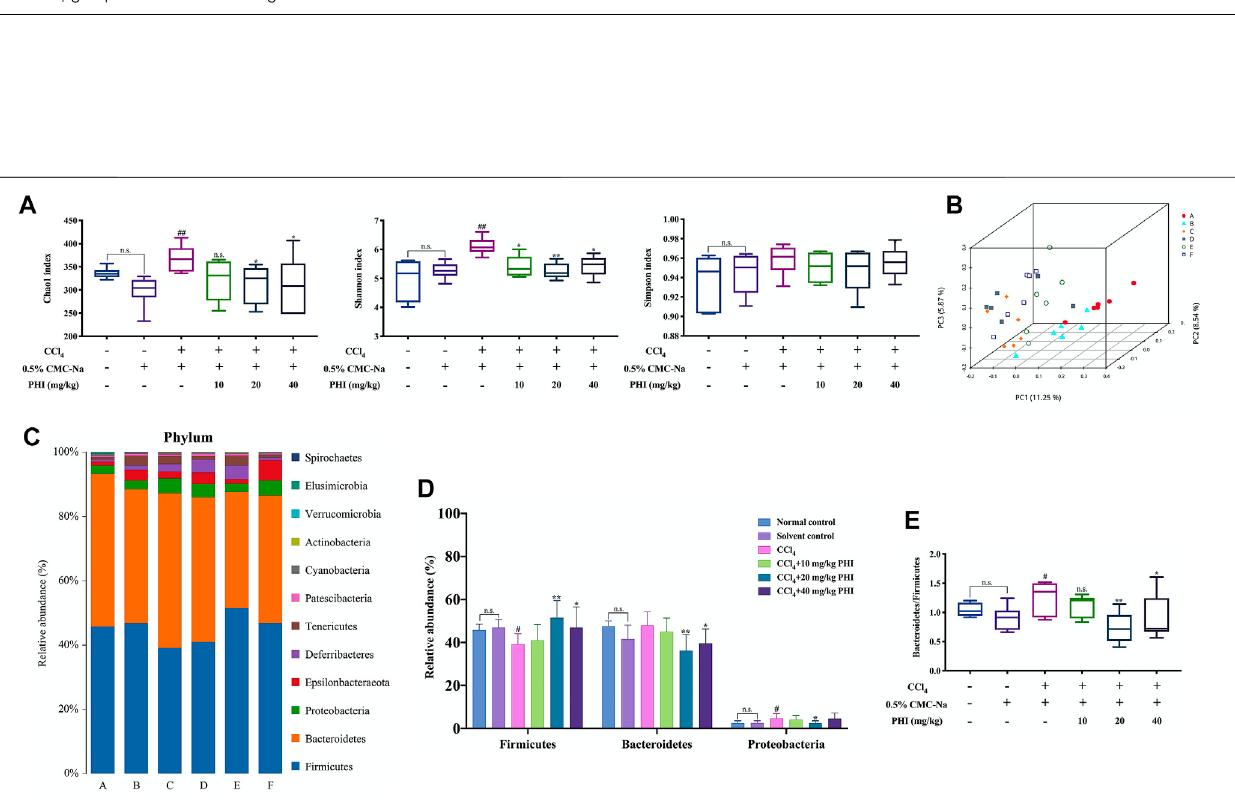
FIGURE 6 | PHI protected intestinal epithelial barrier breakdown induced by CCl 4 . (A) HE staining of ileum ( × 40 and × 200) (B) Villus height. (C) Villus width. (D) Crypt depth. Data was expressed as the mean ± SD ( n (cid:1) 6). ### p < 0.001 represent compared with solvent control group. ** p < 0.01, *** p < 0.001 represent compared with CCl 4 group. n. s indicates no signi fi cant.